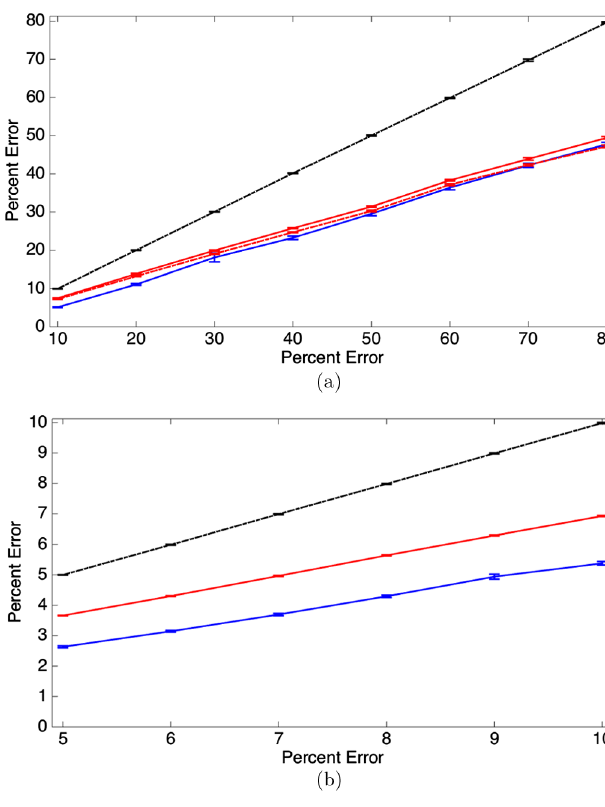
FIG. 3. Filter performance of both the parametric (solid blue curve) and nonparametric (solid red curves) filters when denois- ing the observed Lorenz-63 x variable at increasing levels of (a) large and (b) low observation noise (signal error, dotted black curve). Time series sampled at rate h ¼ 0 . 05 and error bars denote standard error over 10 realizations. Q and R noise covariances are estimated adaptively. The nonparametric filter is able to significantly reduce the signal error to a level comparable to the parametric filter which has full use of the model. In some instances, the performance of the nonparametric filter improves by reprocessing the data (dotted red curve). At higher noise levels, the discrepancy between the parametric and nonparametric filter becomes negligible.